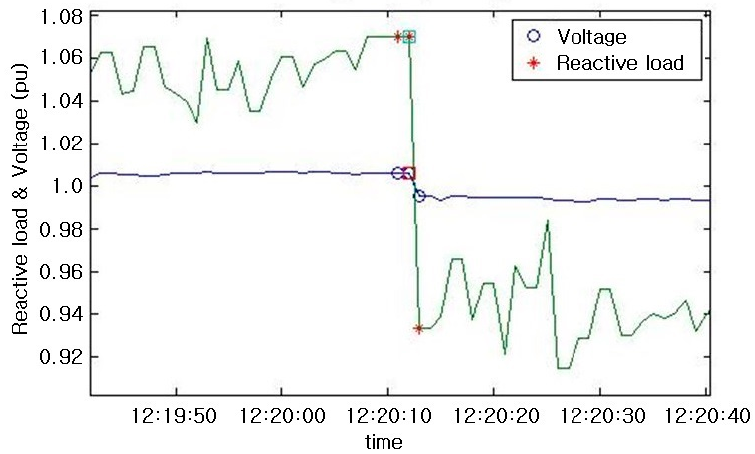
Figure 13. Voltages and loads of the Bookgong D/L.